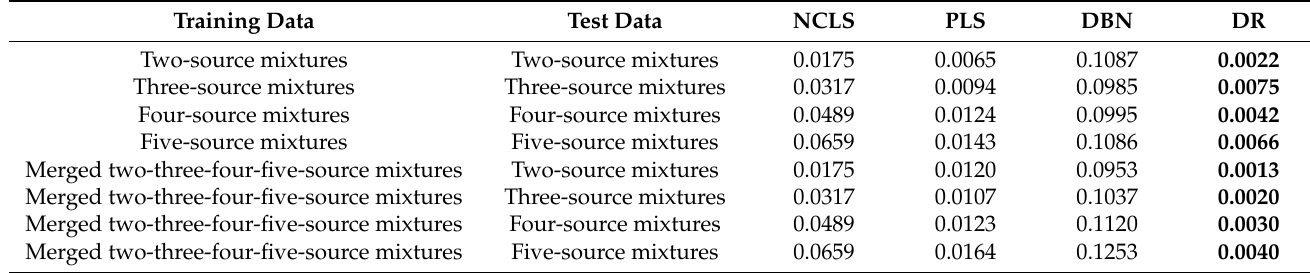
Table 3. Average RMSE results for “high-mixing-rate mixture” dataset (Mixing-rate range used for synthesizing mixtures